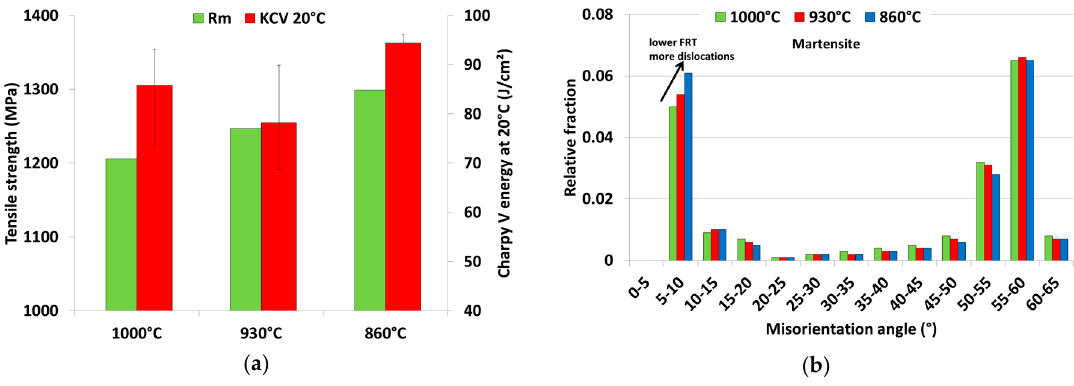
Figure 3. ( a ) Tensile strength and Charpy V impact energy at 20 °C, tested in rolling direction, ( b ) Misorientation angles, based on martensite EBSD map. (DQ1 steel).